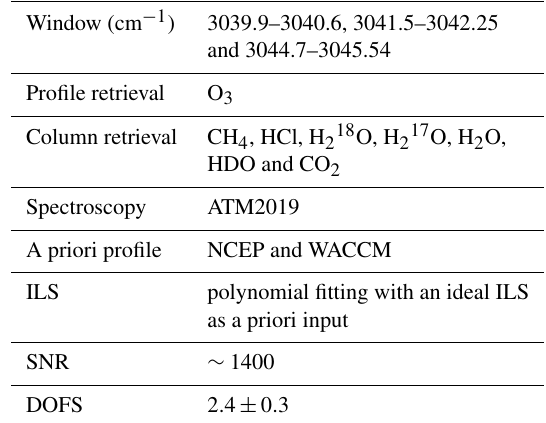
Table 1. The retrieval strategy of the FTIR O 3 measurements using the 3040cm − 1 spectral range at